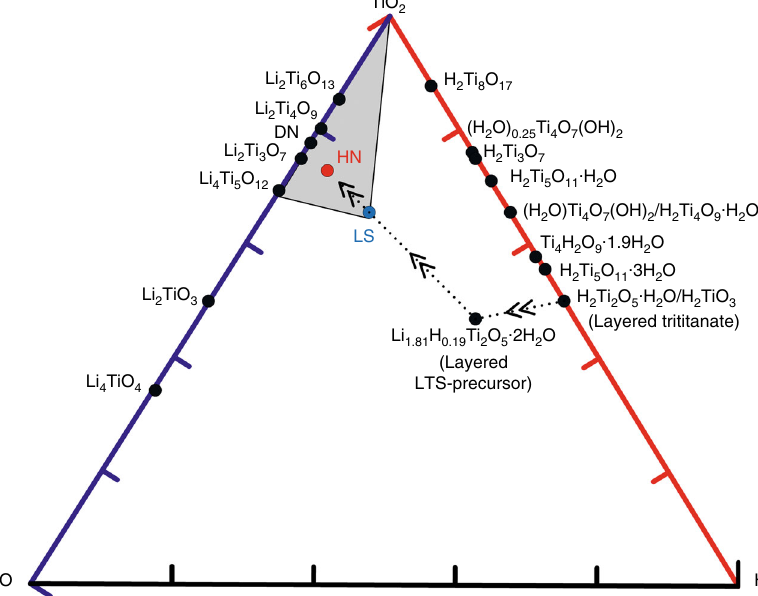
Fig. 1 Calculated ternary phase diagram of Li 2 O – TiO 2 – H 2 O ternary composition space. The arrow demonstrates the ODIN process, the black dot shows the common phase in the Li 2 O – TiO 2 – H 2 O ternary composition space; and the blue dot is the new phase LS; the shadow region illustrate the new mixed phase HN composed of Li 4 Ti 5 O 12 – TiO 2 – LS. See also Supplementary Movie